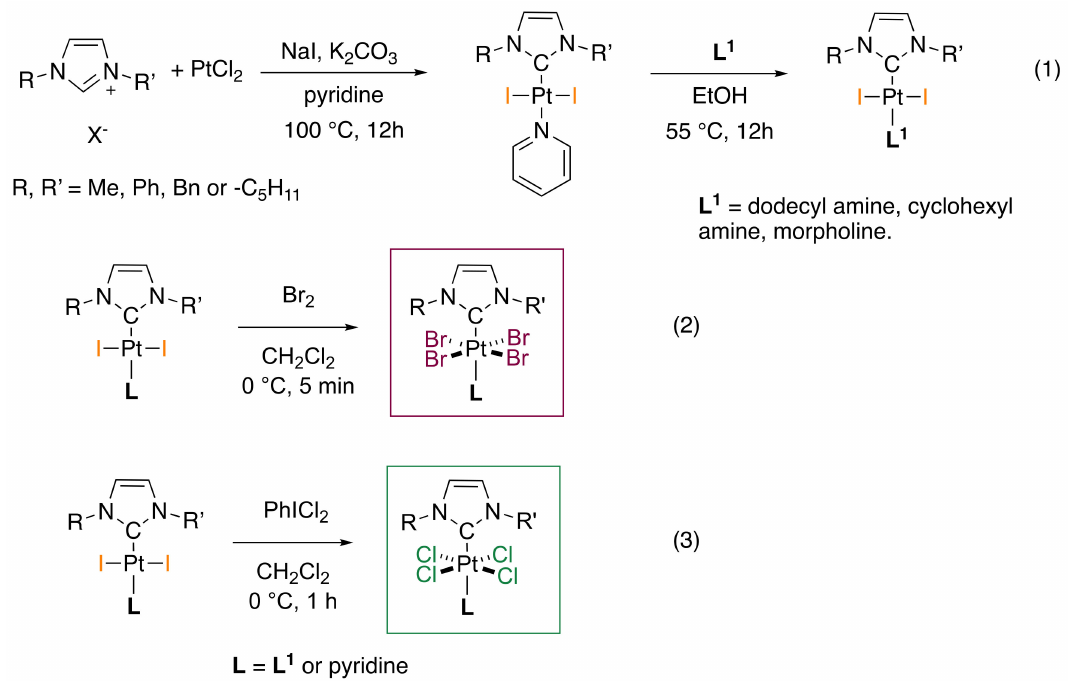
Scheme 1. General synthesis of the platinum (II) and platinum (IV)